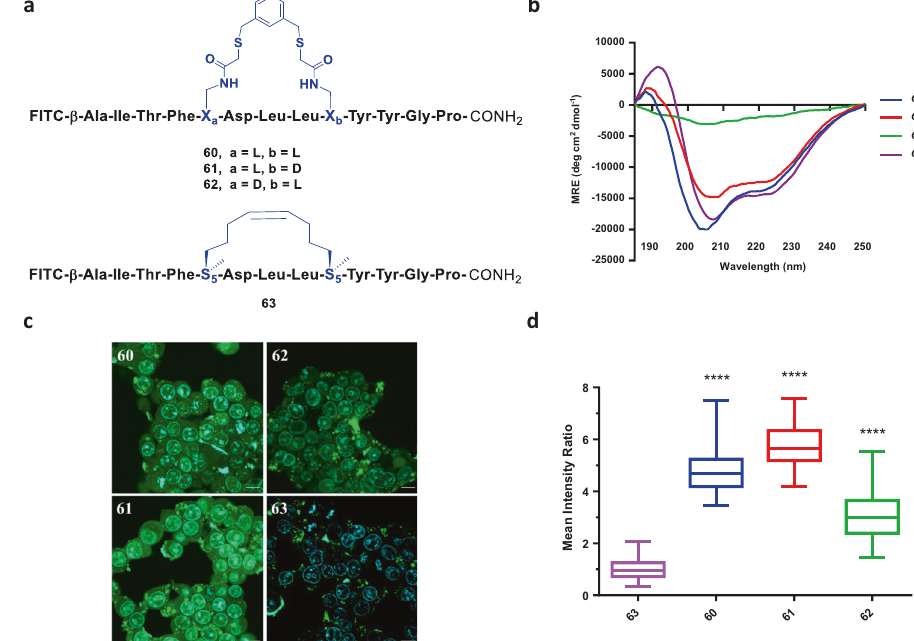
Fig. 5 FTDR-stapled HIV C-CA binding peptide analogues. a Chemical structures of peptides 60 – 62 . The reported HIV C-CA binding peptide 63 (stapled by RCM) was prepared as well. Stapling residues X L /X D /S 5 and the related linkers are highlighted in blue. b CD spectra of the crosslinked peptide analogues. c Fluorescent confocal microscopy images of the HEK293T cells treated with peptides 60 – 63 . Blue: nucleus stained by Hoechst 33342; Green: FITC-labelled peptides; Scale bar: 5 μ m. d Quanti fi cation analysis of the cell penetration of peptides 60 – 63 . The mean intracellular intensity of peptide 63 was normalized as 1. Box plots show 25 – 75% quantiles, median values (bullseye), and minimal and maximal values (whiskers). Two-tailed unpaired t test with Welch ’ s correction has been applied. “ **** ” Represents p < 0.0001. Detailed sample sizes and mean ± SEM values are available at Supplementary